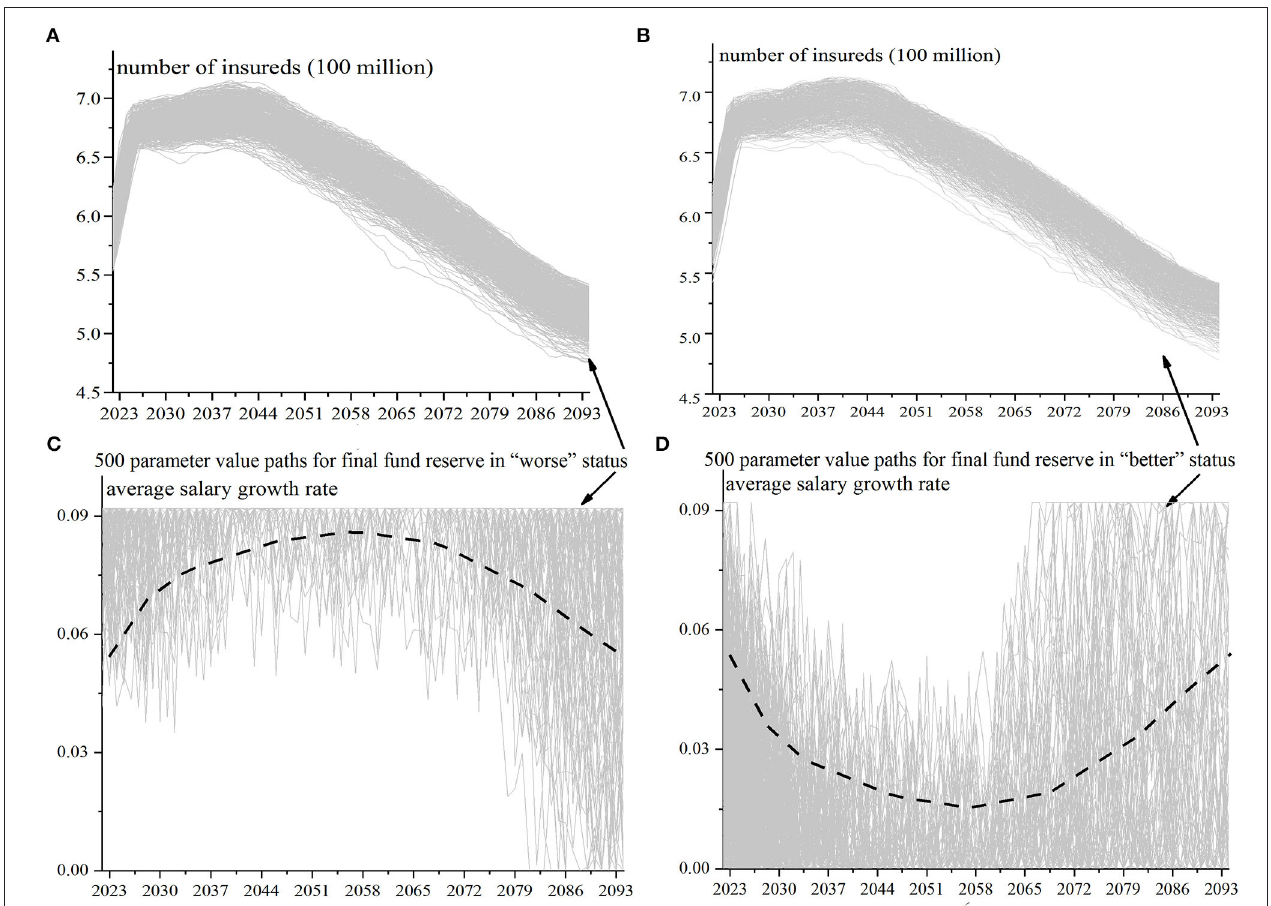
FIGURE 7 | (A–D) Feature search of value paths for the number of insureds and average salary growth rate.